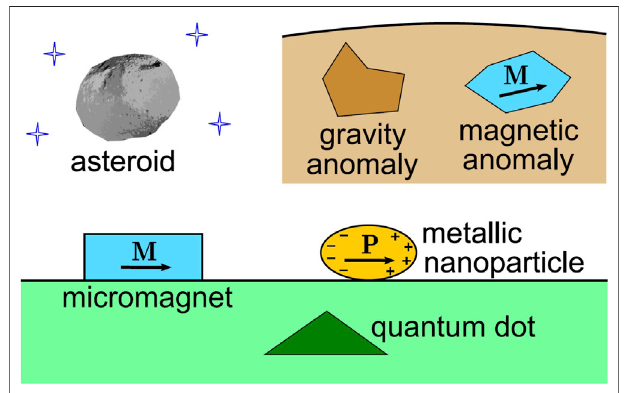
FIGURE 1 | Possible applications of analytical solutions of Eq. 1 : from astronomy (gravitational fi elds of asteroids) and Earth sciences (gravity and magnetic anomalies) to the physics of micro-and nanostructures (magnetic fi elds of nanomagnets, plasmonic resonance of metallic nanoparticles, elastic fi elds of inclusions such as epitaxial quantum